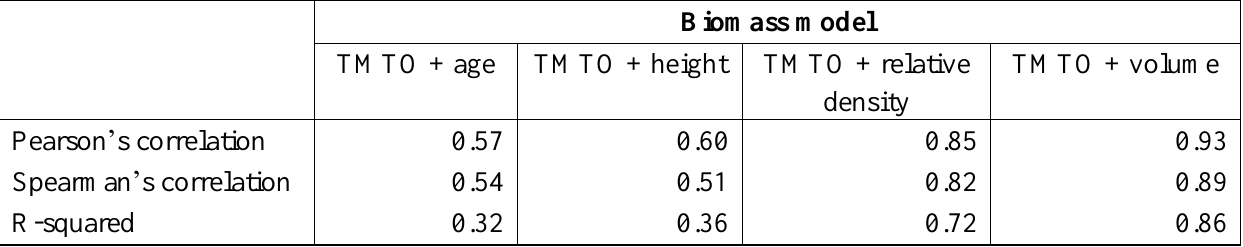
Table 4. Cross-validated results for biomass based on TMTO model and single forest